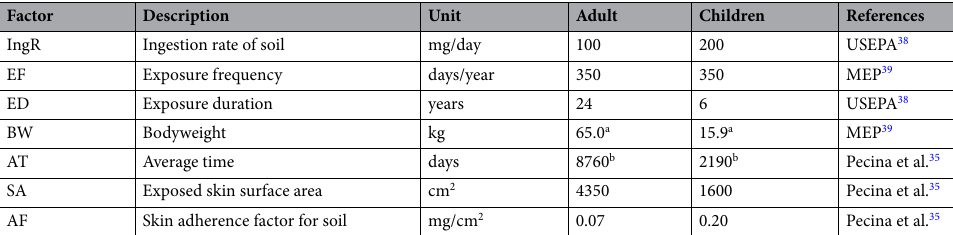
Table 1. Calculation parameters. a BW was calculated as the average of the adult Mongolian weights reported in WHO 40 , Otgontuya et al. 41 , and WHO 42 studies. The Mongolian children’s weight values were not found; therefore, the values from neighbouring China 39 were used. b For carcinogenic effects 43 : LT (lifetime) × 365. In Mongolia 44 , LT = 70. For carcinogenic effects, AT = 25 550.